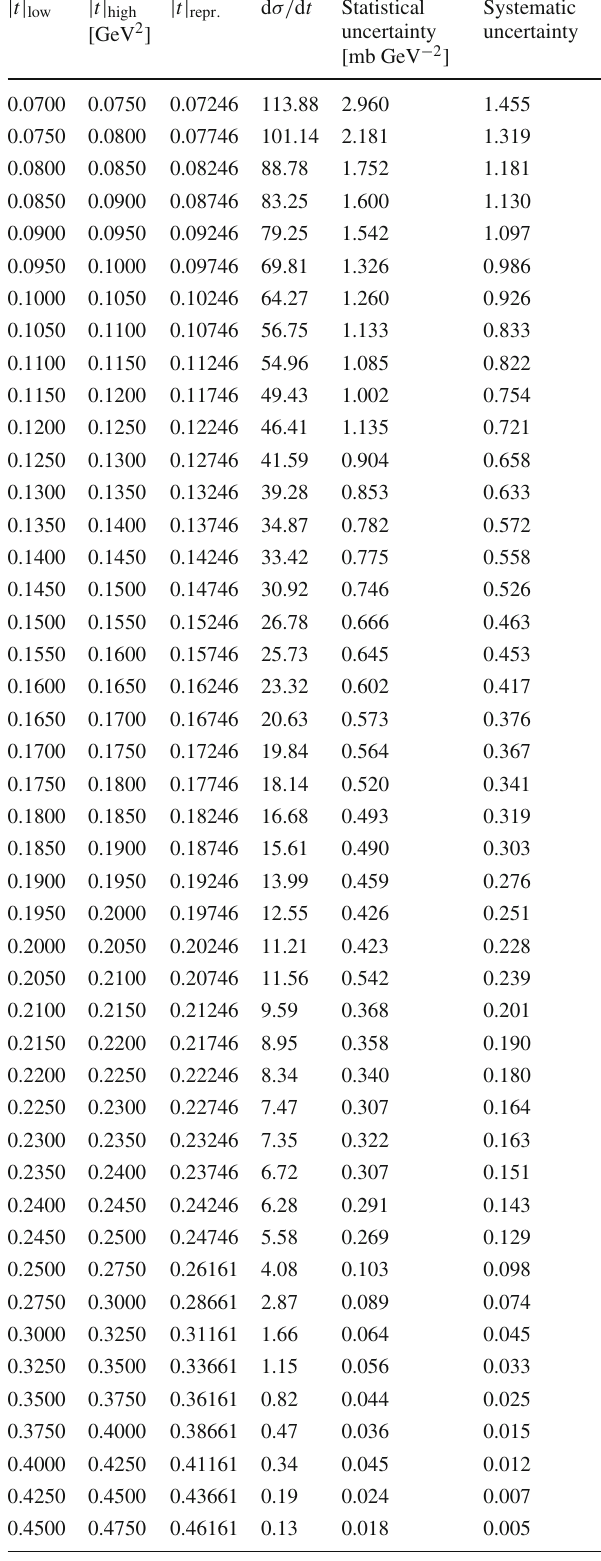
Table 3 The differential cross-section d σ/ d t of DS2 at TeV, measured at 4 . 3 σ beam distance